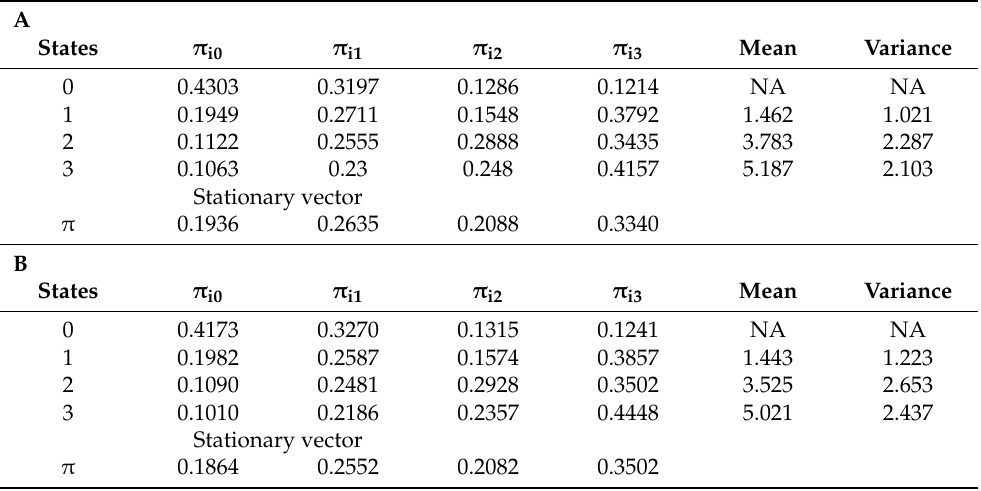
Table 7. A. State-dependent probability matrices for the population without DM2. B. State-dependent probability matrices for the population with DM2.